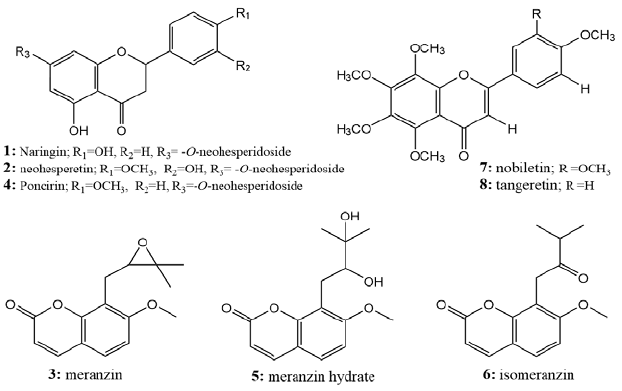
Figure 7 . Structures of the isolated compounds. Figure 7. Structures of the isolated